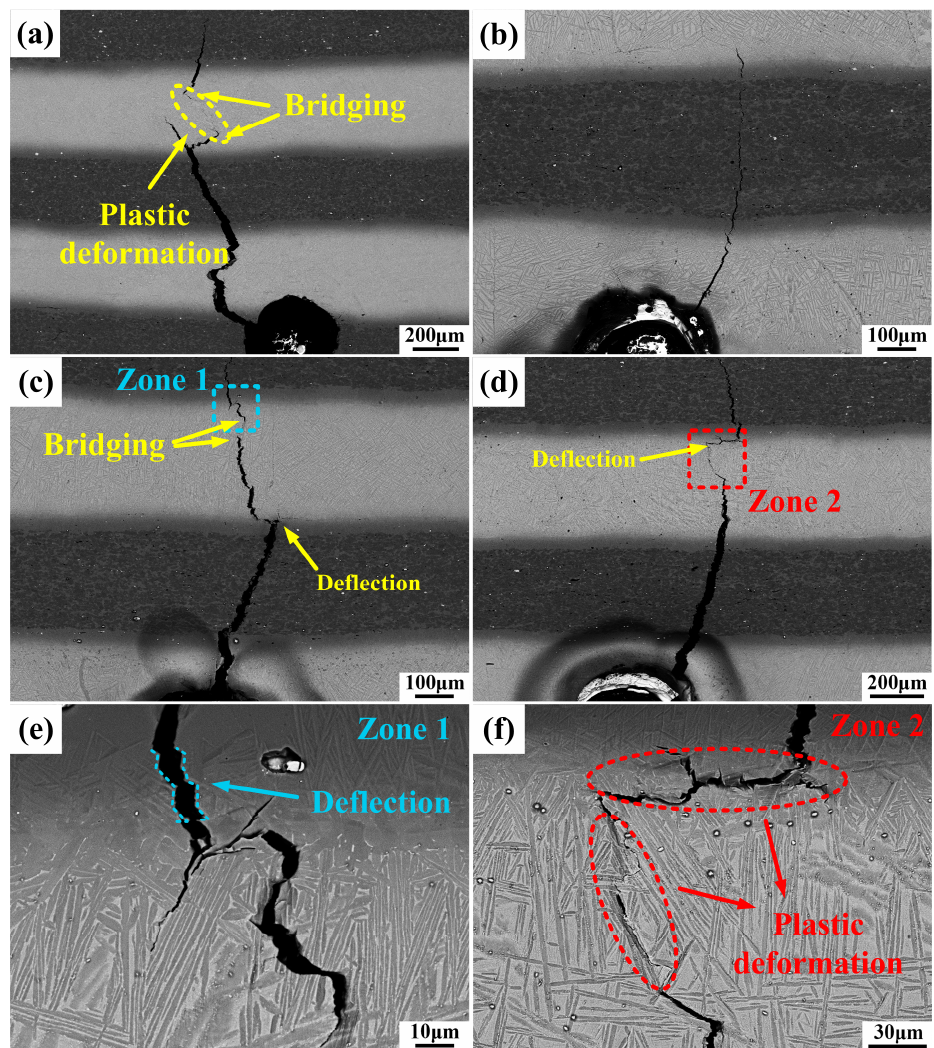
Figure 10. Crack propagation features of the initial and heat-treated composites: ( a ) initial composite, ( b ) HT1, ( c ) HT3, ( d ) HT5 and ( e , f ) magnified areas of picture ( c , d ), respectively.